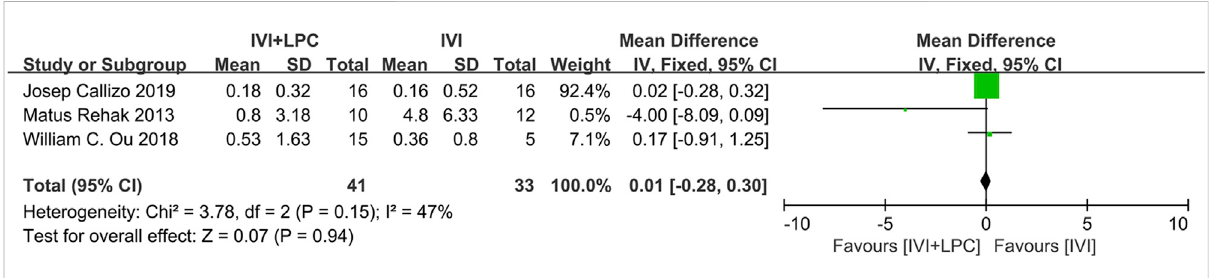
FIGURE 6 Comparison of the change of NPAs areas between combination(IVI + LPC) treatment group and single IVI treatment